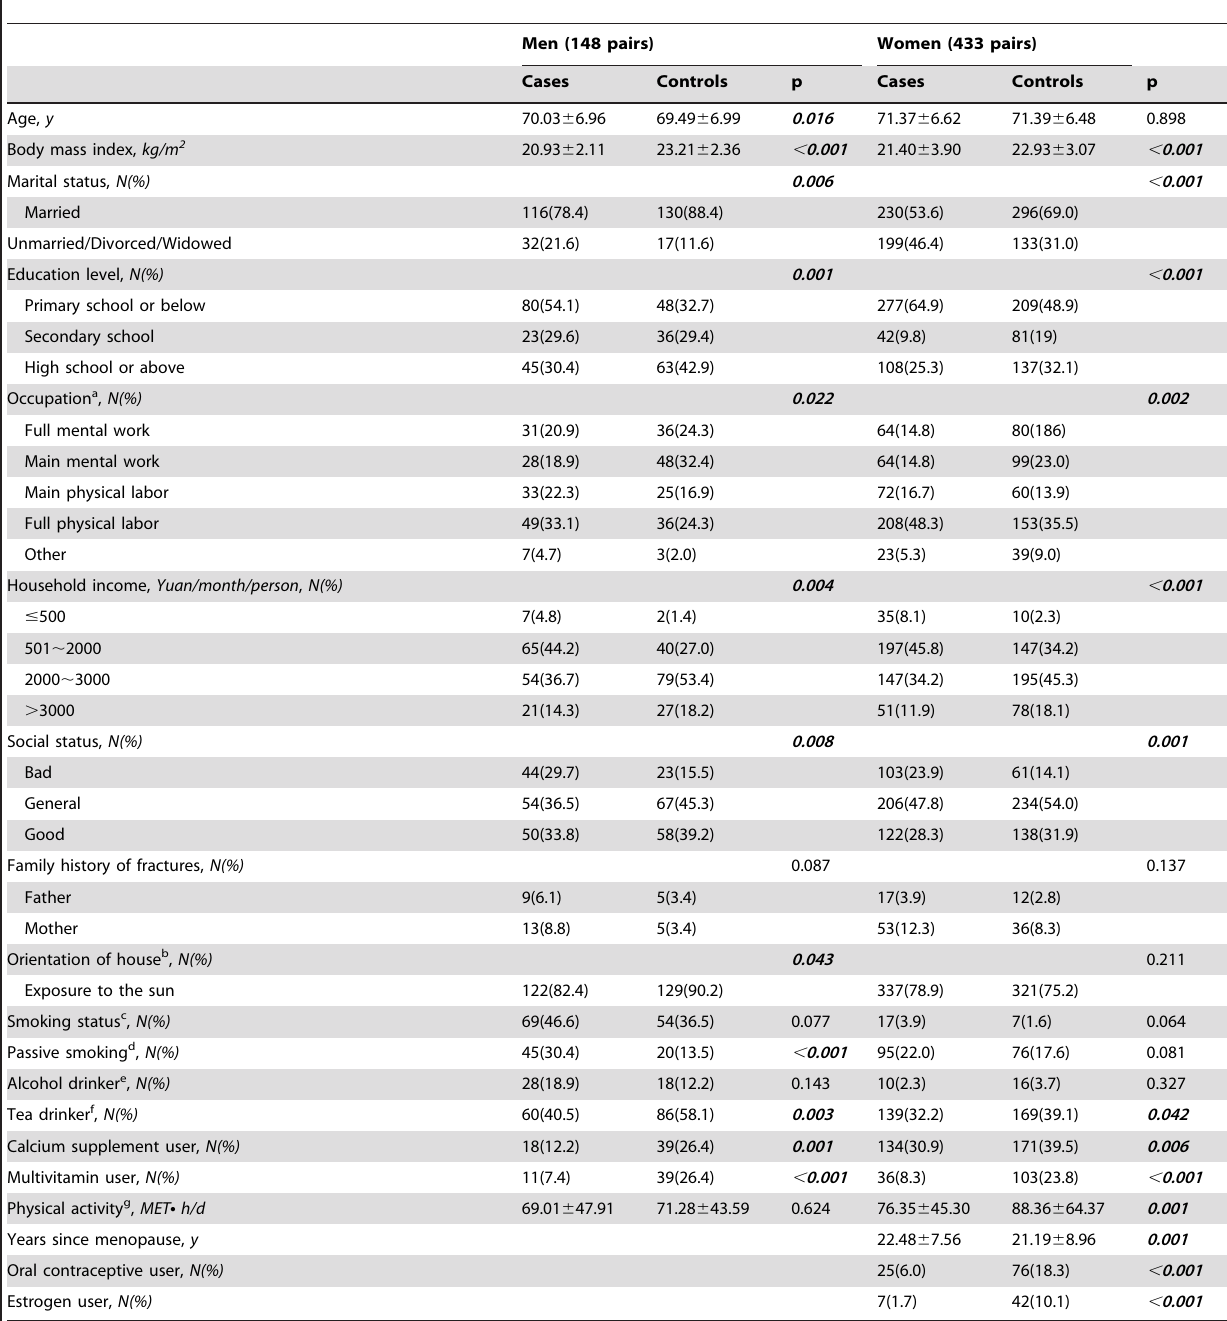
Table 2. Demographics, lifestyle characteristics, and select hip fracture risk factors of study population in Guangzhou,